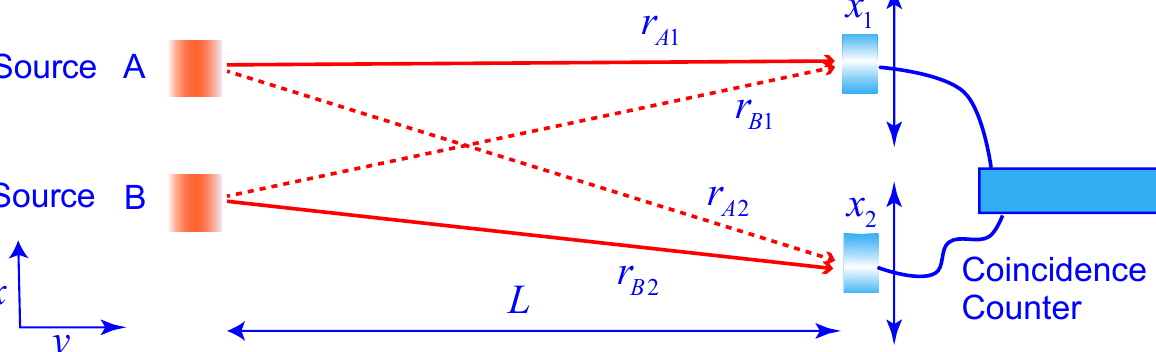
Figure 1: A schematic diagram for a two source interference, and also for a intensity correlation at two points. Sources A and B are stationary while the detectors at x 1 and x 2 are